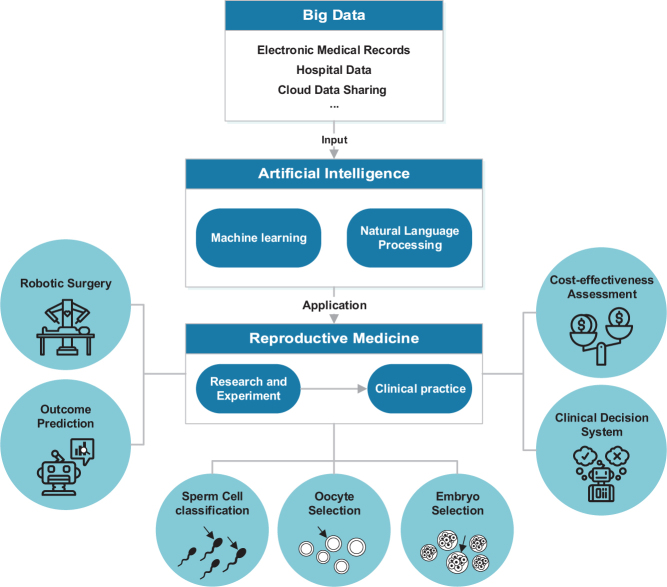
The role of artificial intelligence in Reproductive Medicine. Big data include electronic medical records (EMRs) and other data. EMRs can capture data from various ways and the data is analyzed using AI such as machine learning and natural language processing (NLP). AI has been used in the many aspects of reproduction, from research and experiment to clinical practice. This schematic reviews the seven main applications of AI in reproductive medicine.